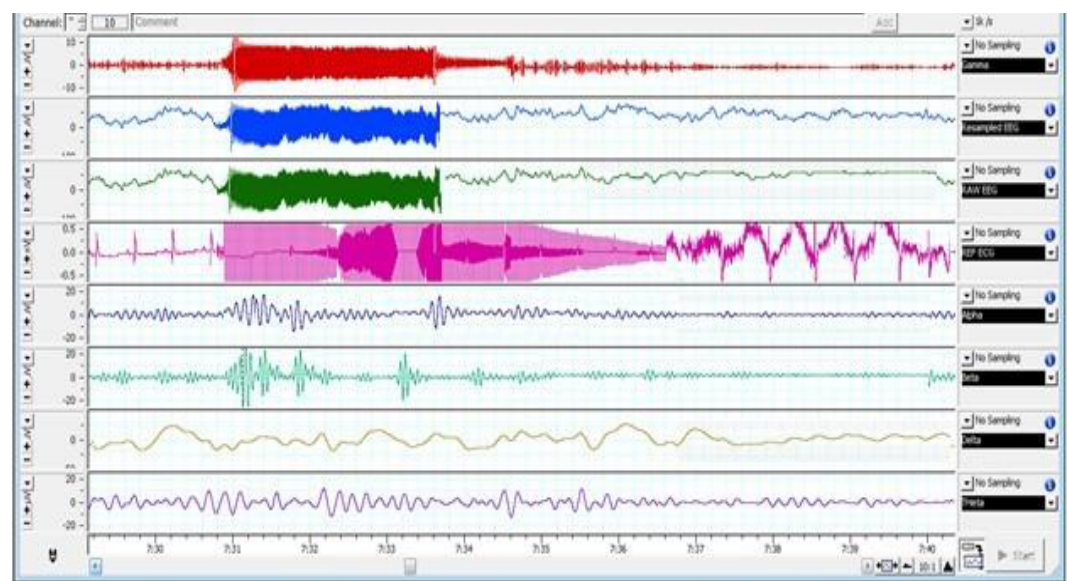
Figure 3. EEG Changes in Goats Subjected to Low-Frequency Head-Only Electrical Stunning.